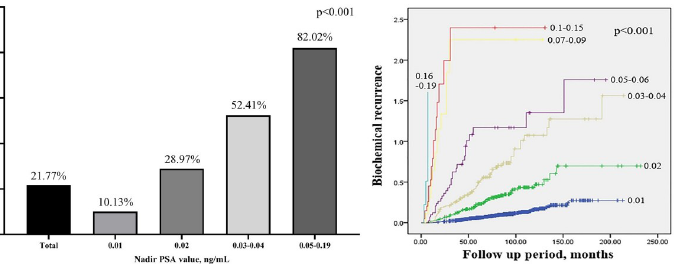
Fig 1. Biochemical recurrence after radical prostatectomy by nadir prostate specific antigen level. Chi-square test, Kaplan-Meier curve of biochemical recurrence by nadir prostate specific antigen value.